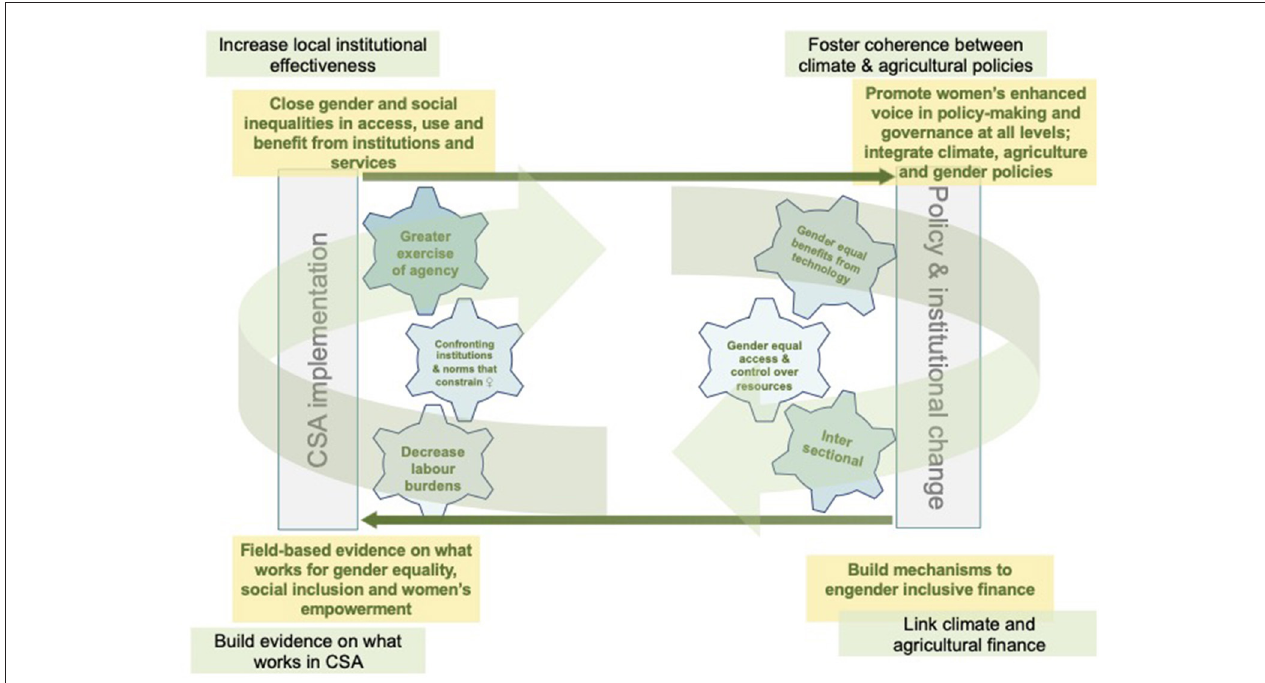
FIGURE 2 | Gender equality and empowerment in climate-resilient